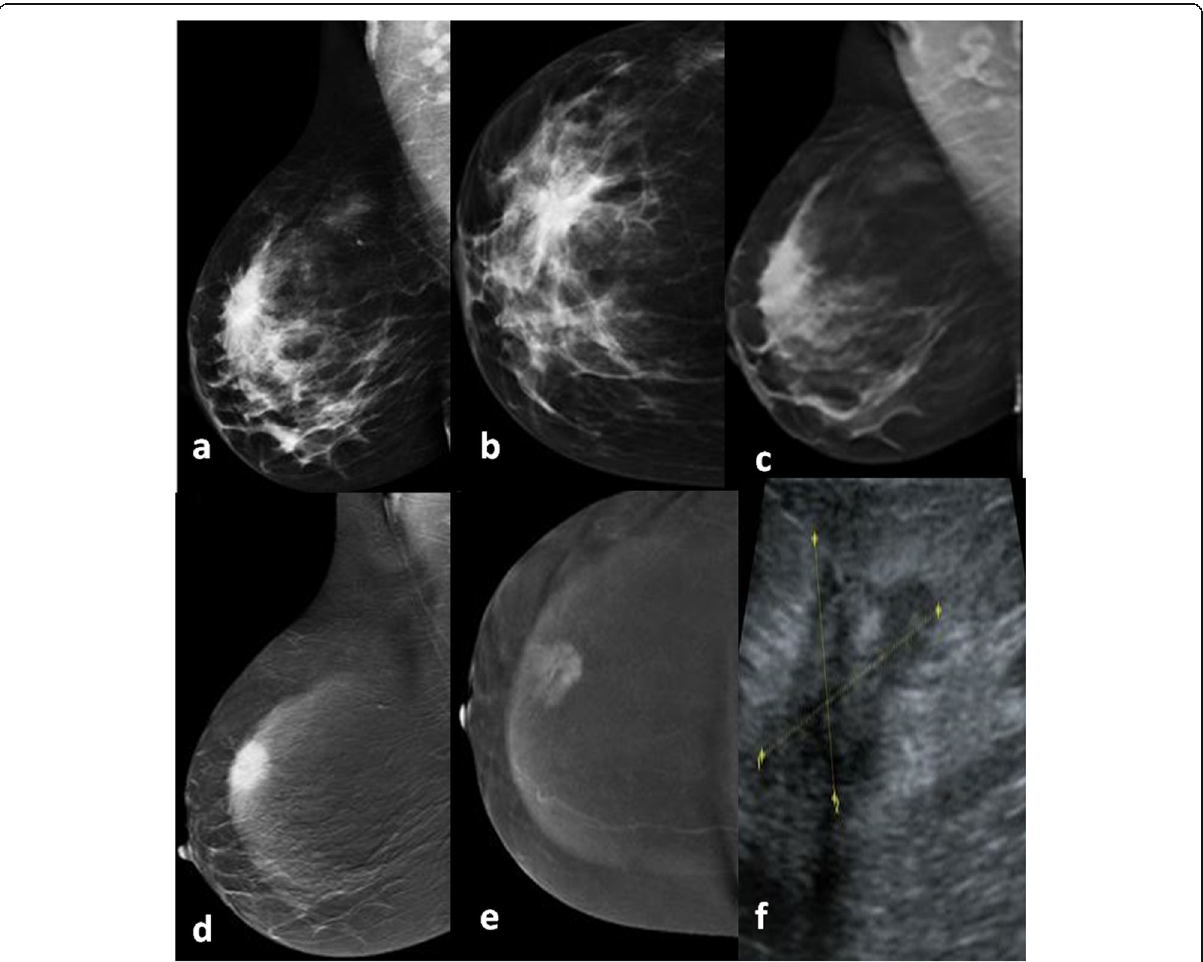
Fig. 2 A 48-year-old patient came for screening. Mammography and DBT revealed spiculated mass in the right upper outer quadrant ( a – c ). CEM showed an intense heterogeneous enhancing mass in the right upper outer quadrant with not circumscribed spiculated margins ( d , e ). Breast ultrasound showed an irregular ill-defined speculated hypoechoic mass with posterior shadowing ( f ). The final diagnosis was invasive duct